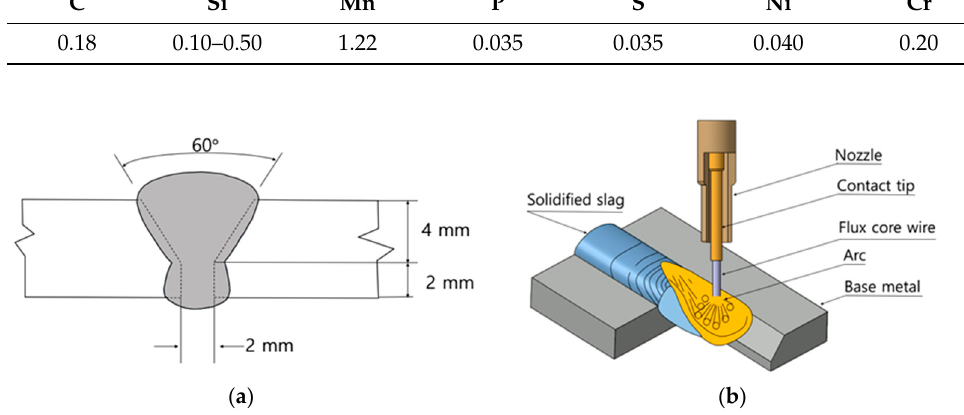
Figure 1. ( a ) Geometry of the Y-groove joint and ( b ) schematic diagram of the FCAW process.